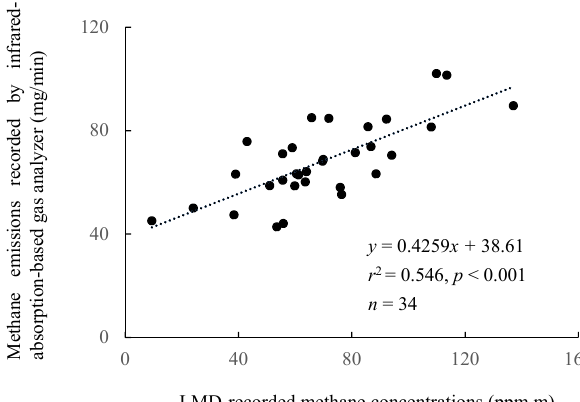
Figure 2. Linear regression of methane concentrations recorded by laser methane detector (LMD, x ) versus average methane emissions recorded by infrared-absorption-based gas analyzer for 60 min after LMD measurement ( y ) in Experiment 1. For both measurements, the cattle (Simmental beef cattle) were held in respiration chambers. LMD-recorded methane concentration ( x ) of each datapoint was the mean value of methane concentrations (ppm m) , which were considered to represent methane emissions by respiration in each hourly measurement.